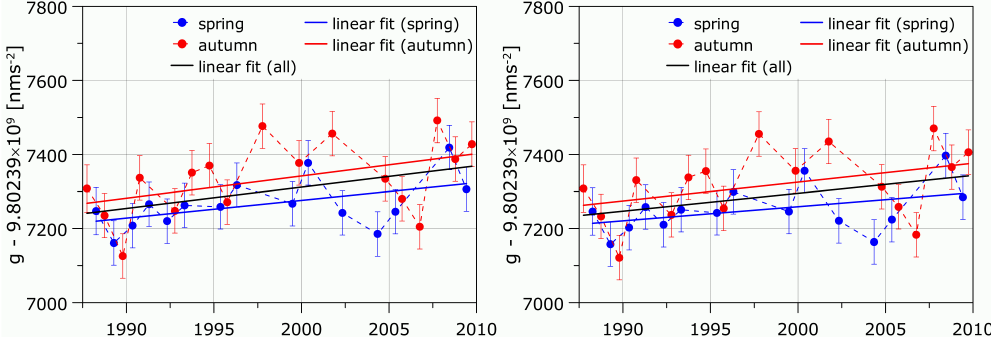
Fig. 6. Gravity variation at Obergurgl corrected for the effect of glacial ablation based on the scenario 2 (left) and scenario 3 (right). Scenario 3 represents the maximum possible gravity increase due to ice